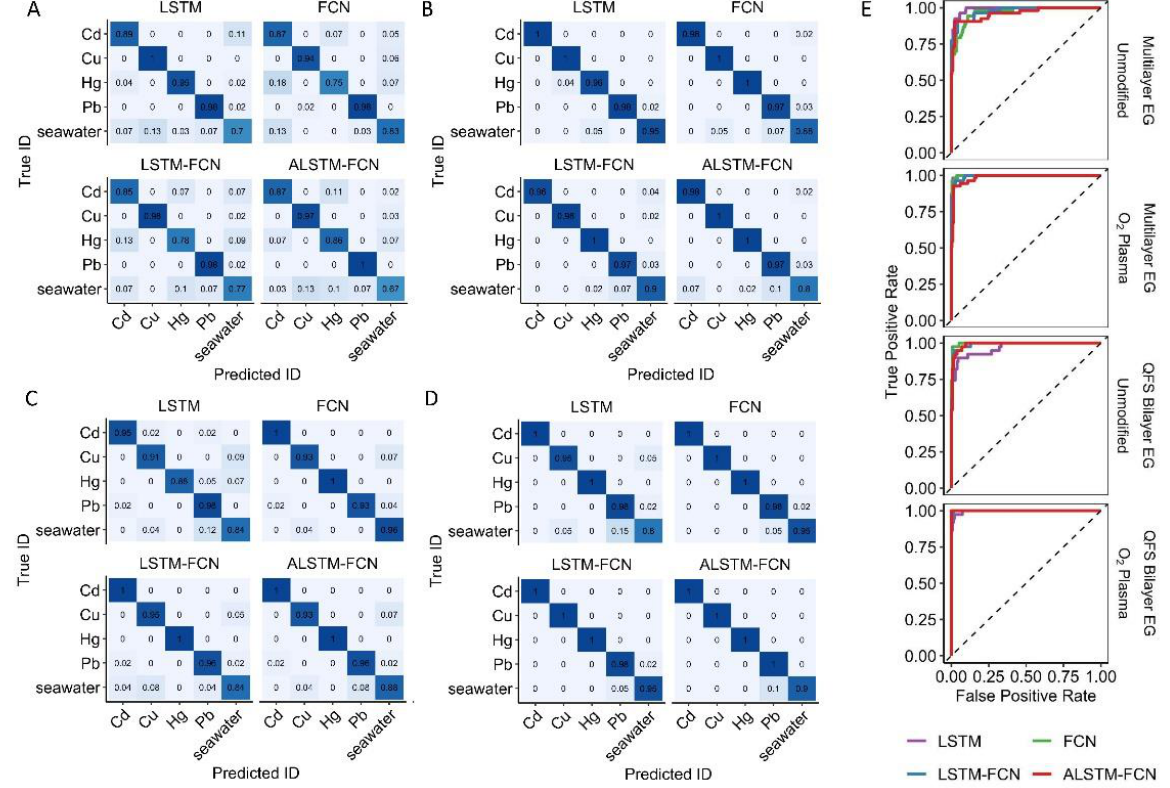
Figure 7. Confusion matrixes comparing the different machine learning models for the library of cyclic square wave voltammograms of seawater spiked with heavy metal salts at different types and modifications of EG. ( A ) Multilayer EG. ( B ) Oxygen-modified multilayer EG. ( C ) Hydrogen- intercalated QFS bilayer EG, and ( D ) Oxygen-modified hydrogen-intercalated QFS bilayer EG. ( E ) Receiver Operating Characteristic (ROC) curves for same data comparing the different machine learning models with the different types and modifications of EG.